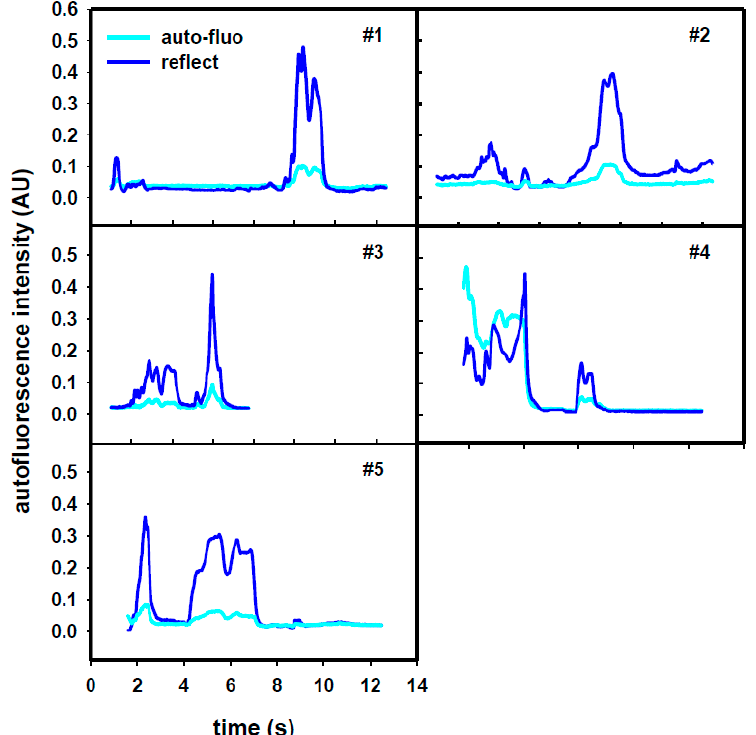
Figure 4. The time-trace profile of needle puncture from skin to epidural space. A total of 5 different paravertebral sites for puncture were recorded. The reflection (Blue) and fluorescence (Cyanate) are simultaneously measured for double assurance of ligamentum flavum detection. The puncture speed is not a constant and consequently the time course should not be expressed as distance or thickness of the tissues.